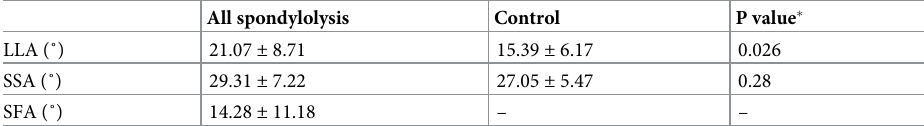
Table 1. Measured data for all spondylolysis and control